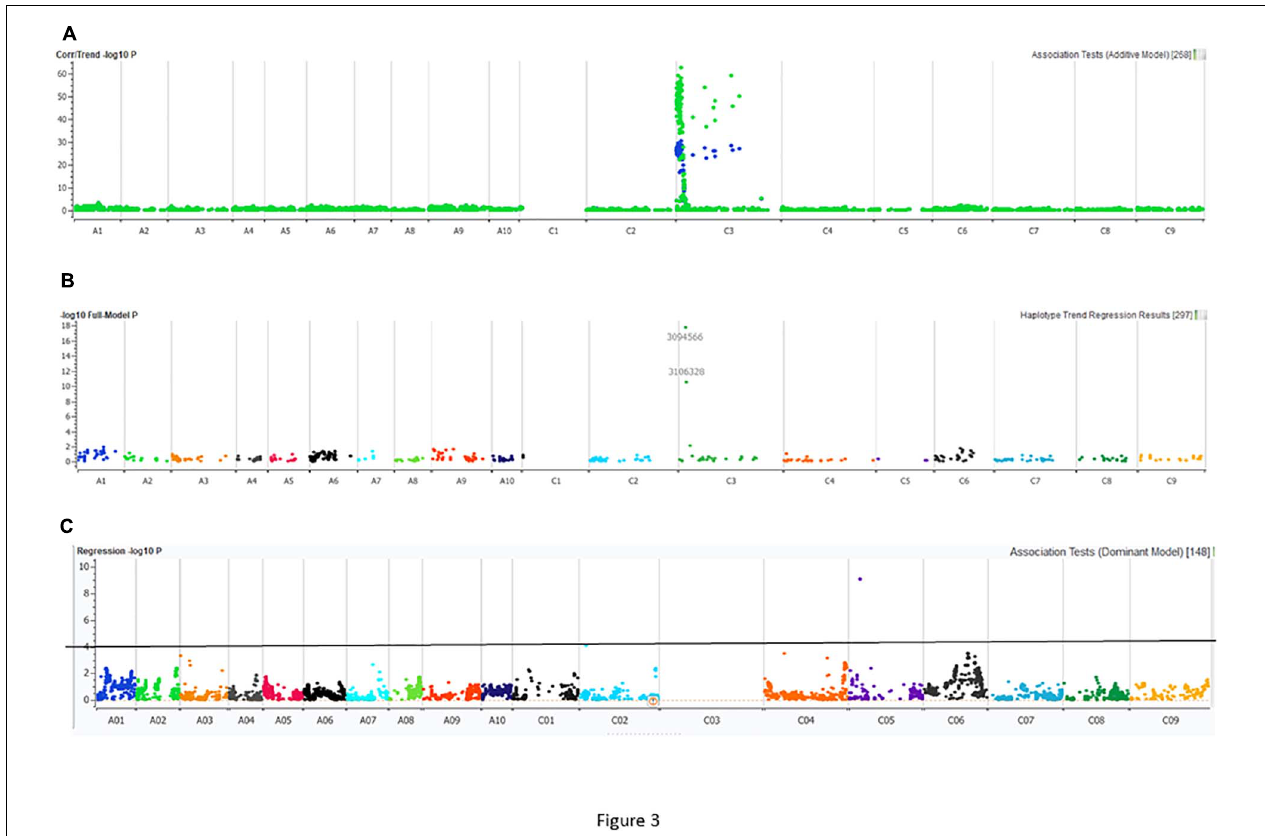
FIGURE 3 | Manhattan plots describing marker associations for resistance to the PHW1223 isolate of L. maculans in an intercross population derived from CB-Telfer/ATR-Cobbler. Resistance to L. maculans was assessed at the cotyledon stage under glasshouse conditions. (A) Markers highlighted in green represent associations detected for resistance to the PHW1223 isolate using linear marker regression (additive model), and those in blue represent associations detected for resistance to the PHW1223 isolate using correlation/trend (additive model). (B) Marker associations identified for resistance using haplotype trend regression. (C) Marker association identified for resistance to PHW1223 isolates (without markers mapped on chromosome C03). Different colors represent chromosomes of B. napus (A01–A10 and C01–C09). Significant associations with a − log 10 P ≤ 3 are shown with a solid horizontal line (in black).